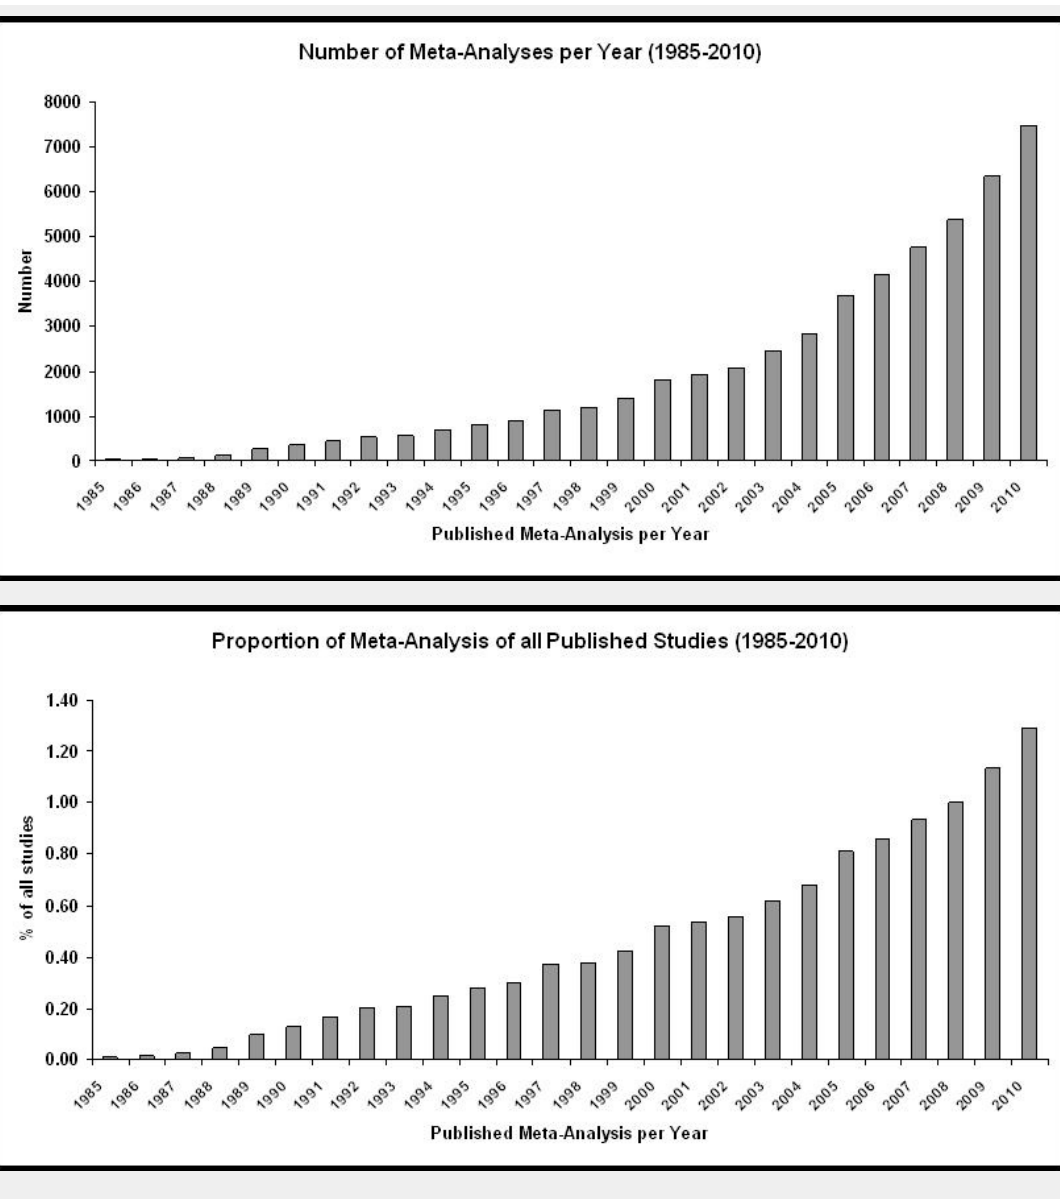
Figure 1 A: Increase in number of meta-analyses in MEDLINE (meta-analysis[mh] OR meta-analysis[pt] OR meta-anal*[tw]) from 1985 to 2010. B: Increase in proportion of meta-analyses of all published studies in MEDLINE from 1985 to